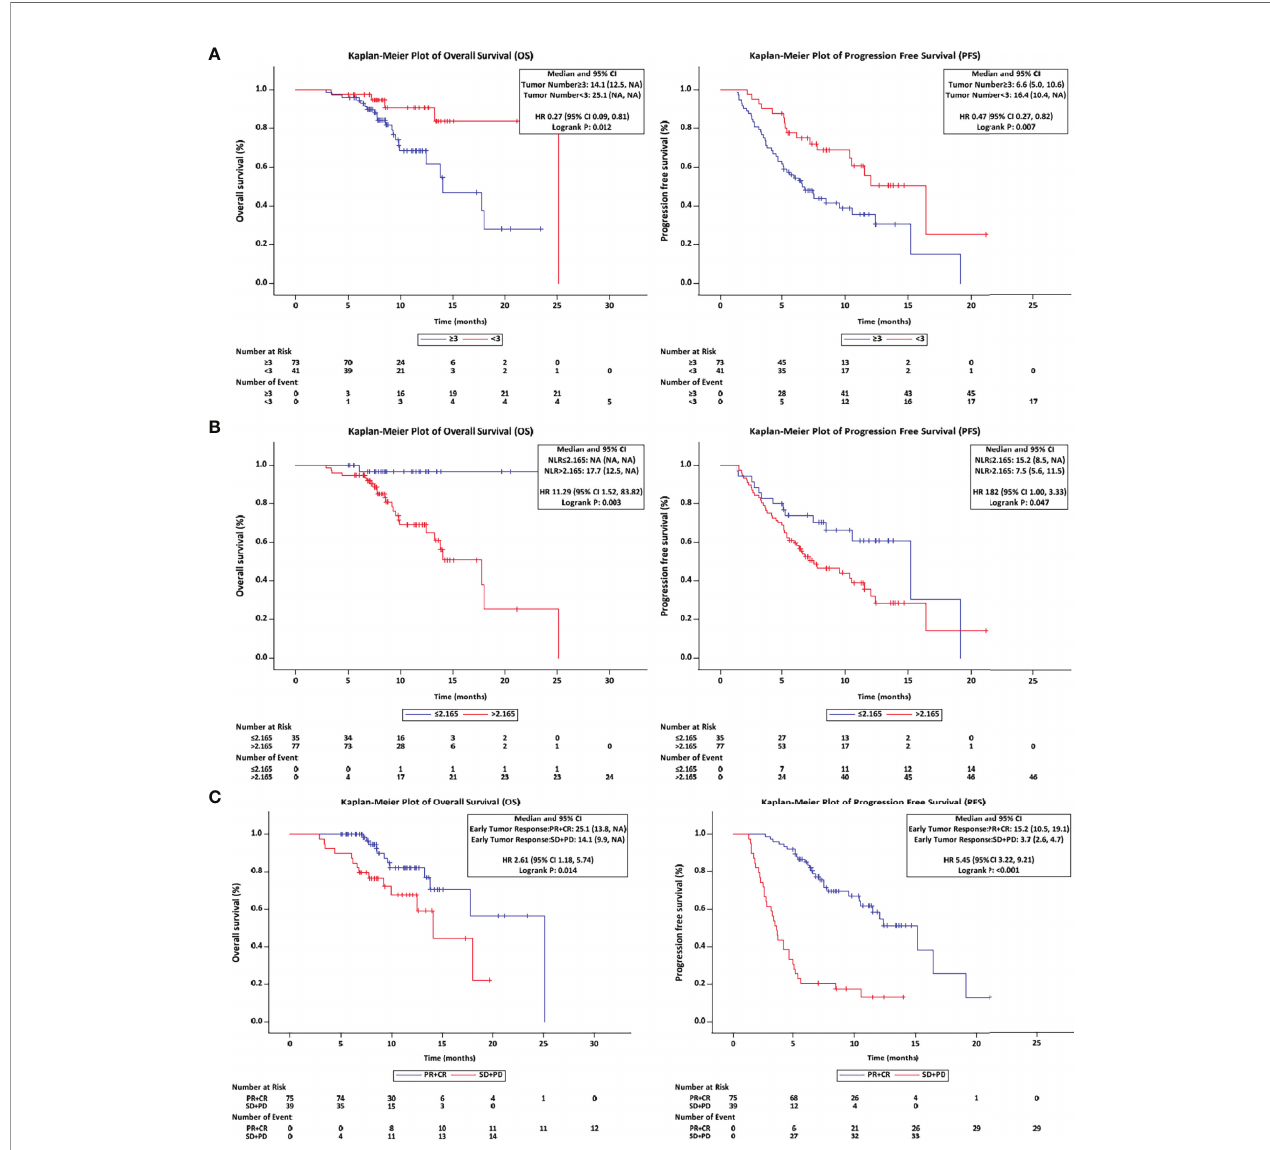
FIGURE 4 | Overall and progression-free survival with different strati fi ed. (A) The OS and PFS in tumor number ( ≥ 3 vs. < 3) patients. (B) The OS and PFS in NLR ( ≤ 2.165 vs. > 2.165) patients. (C) The OS and PFS in early tumor response (CR+PR vs. SD+PD) patients. OS, overall survival; PFS, progression-free survival; NLR, neutrophil lymphocyte ratio; CR, complete response; PR, partial response; SD, stable disease; PD, progressive